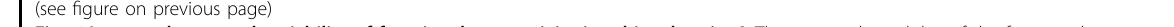
Fig. 6 Increased temporal variability of functional connectivity in schizophrenia. A The temporal variability of the functional connectivity of different Automated Anatomical Labeling atlas 3 (AAL3) brain regions in chronic schizophrenic and control groups. The temporal variability of the functional connectivity measures how much the functional connectivity of a brain region with other brain regions changes across time 75,78 . B The mean (across time) functional connectivity of AAL3 areas for the chronic schizophrenic group minus controls. The lower left shows the t value for the difference in functional connectivity of patients — controls; the upper right shows the signi fi cance after Bonferroni correction. The functional connectivity is measured by the Pearson correlation between the BOLD signals in a pair of brain regions. The brain regions shown are from the AAL3 atlas 76 . (After Rolls et al. 75